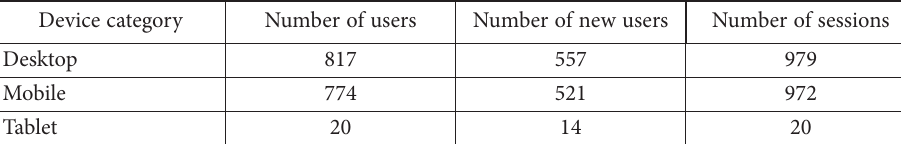
Table 2. Number of users by device category (source: created by authors) Device category